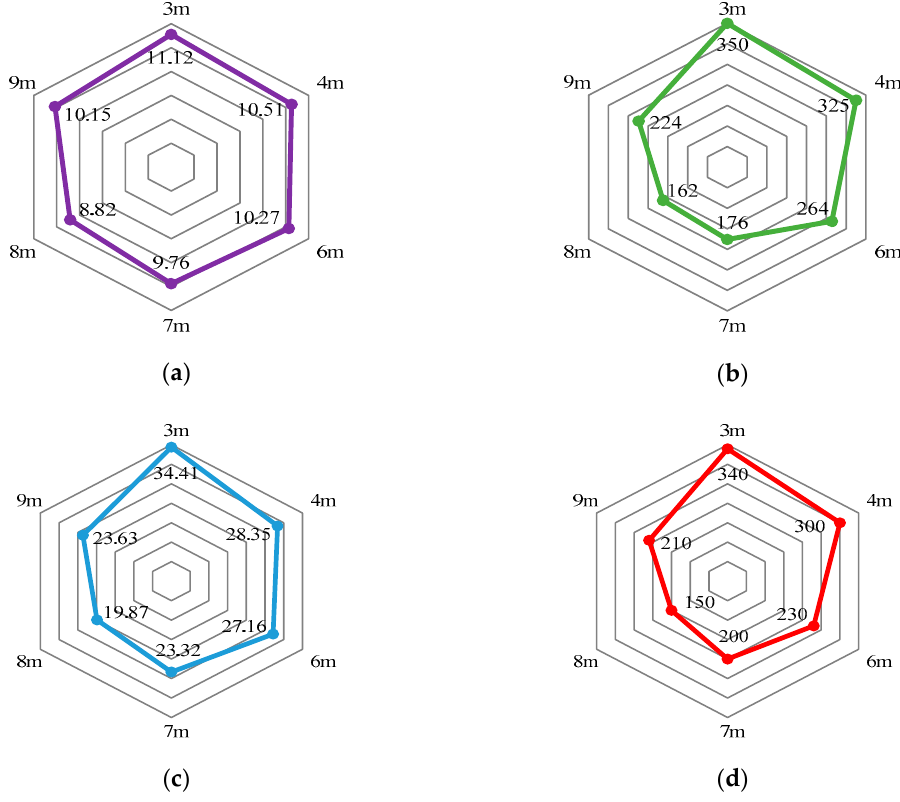
Figure 17. Numerical simulation results for different cutting heights. ( a ) Coal wall vertical stress, MPa; ( b ) Coal wall horizontal displacement, mm; ( c ) Roadside prop vertical stress, MPa; ( d ) Roadside prop vertical displacement, mm.